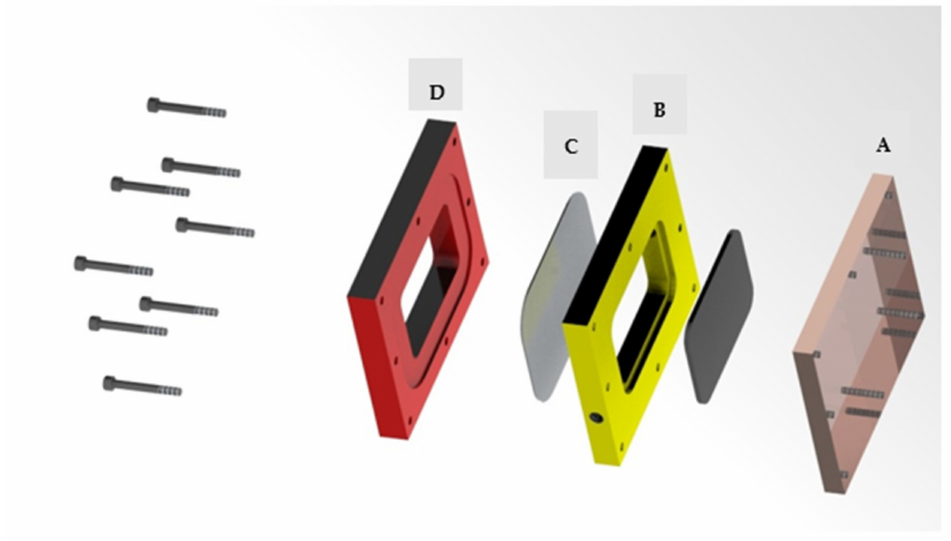
Figure 1. Schematic configuration of a Microbial Fuel Cell (A: End Plate; B: Anode Chamber; C: Membrane; D: Cathode